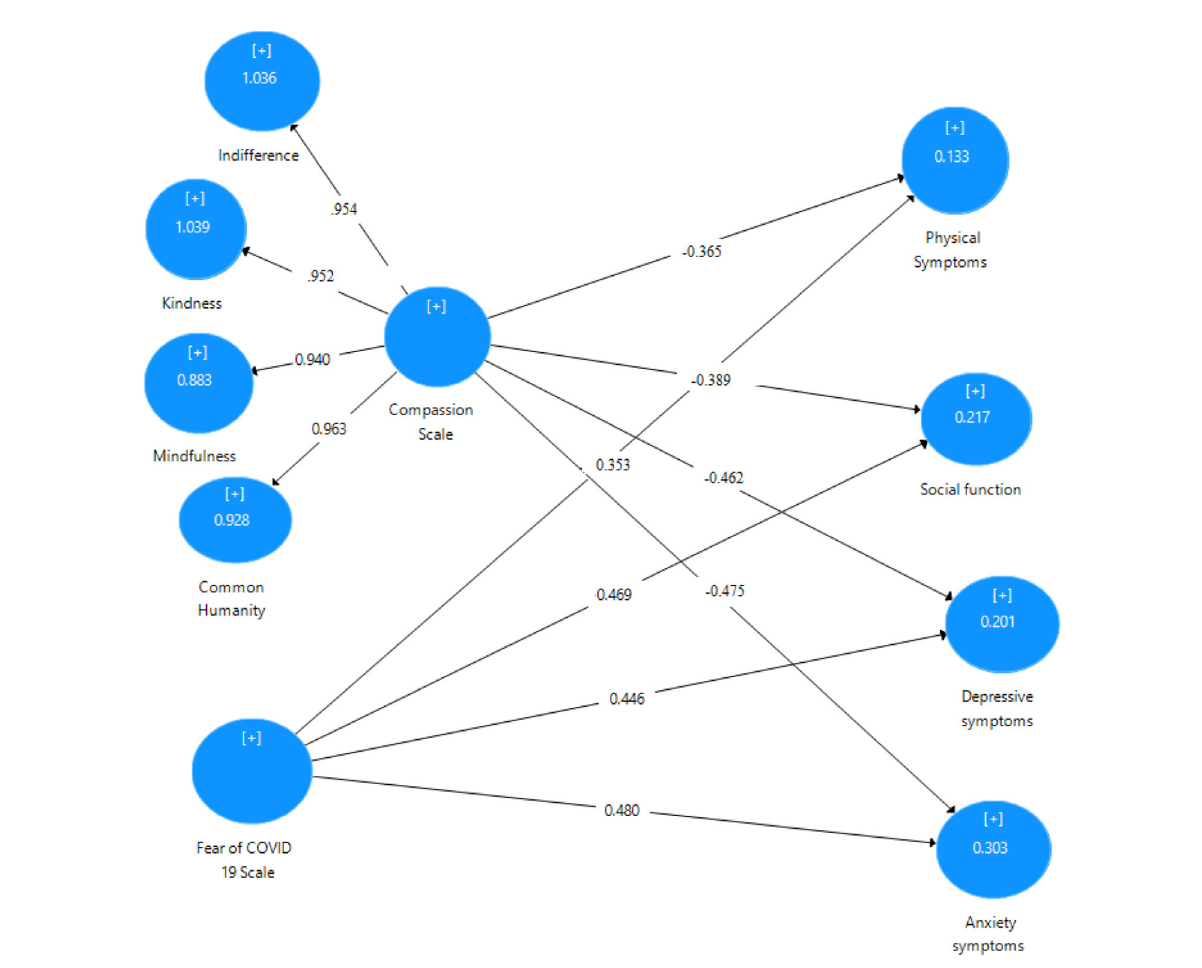
FIGURE1 Structural model for general health